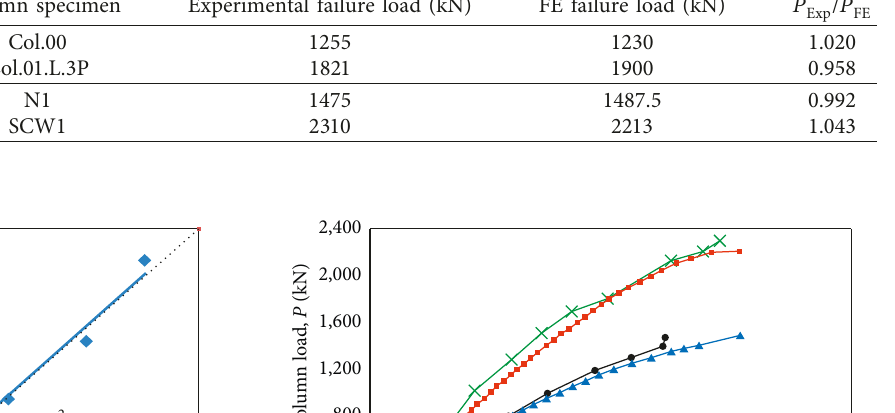
Studies FE model based on